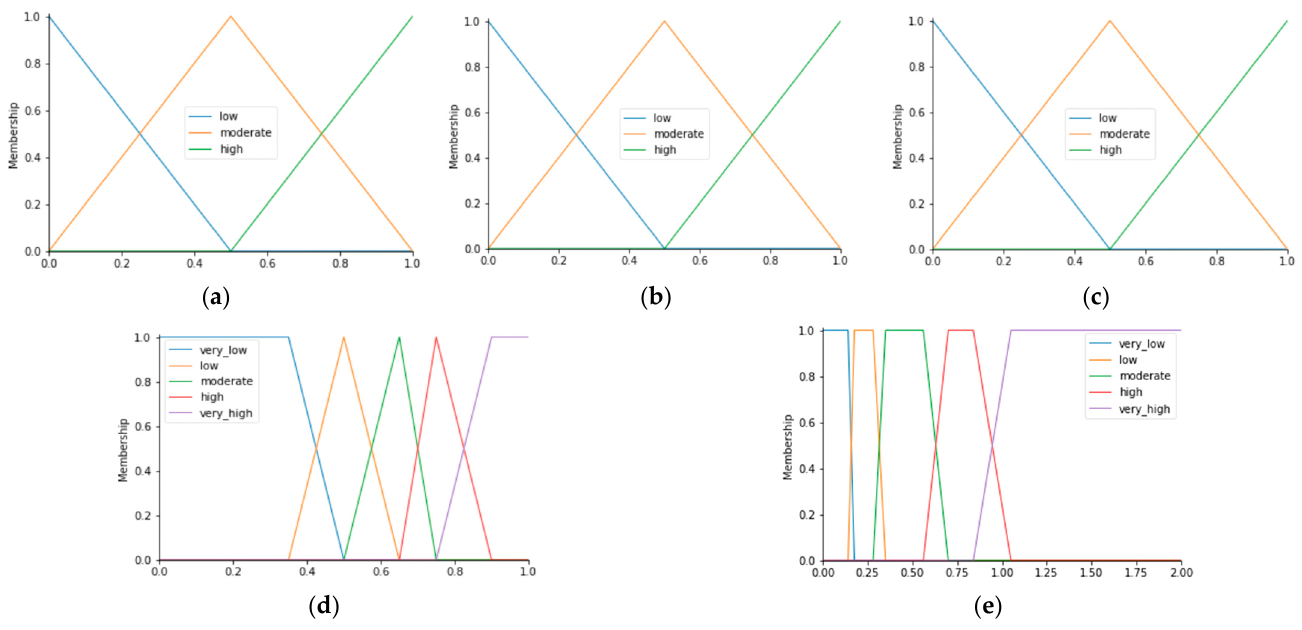
Figure 7. Membership functions of intermediate variables: ( a ) increase demand; ( b ) decrease resistance; ( c ) structural deficiency; ( d ) building vulnerability; and ( e ) site seismic hazard.